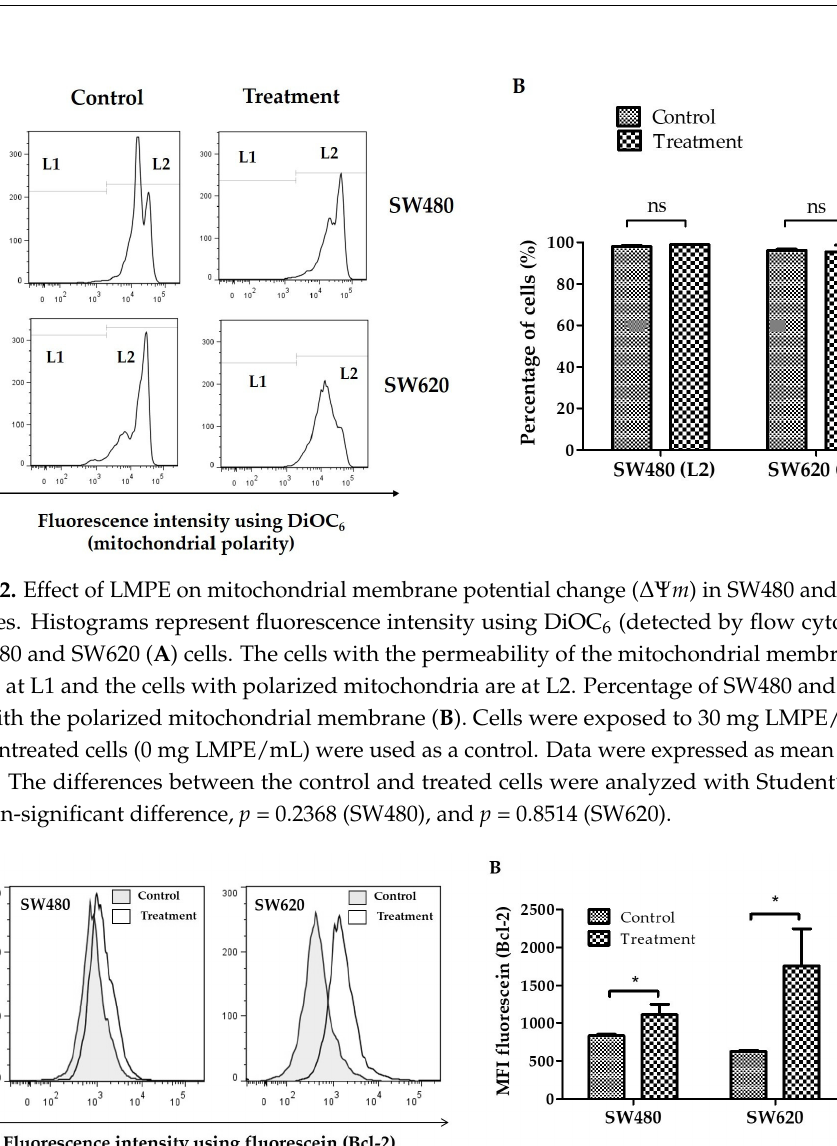
Figure 3. Effect of LMPE on Bcl-2 expression in SW480 and SW620 cell lines. Histograms represent fluorescence intensity using anti-Bcl-2, mouse monoclonal and goat anti-mouse IgG (H + L), fluo- rescein conjugate (detected by flow cytometry) in SW480 and SW620 ( A ) cells. Bcl-2 expression is indicated by the mean fluorescence intensity (MFI) of fluorescein in SW480 and SW620 ( B ) cells. Cells were exposed to 30 mg LMPE/mL for 48 h. Untreated cells (0 mg LMPE/mL) were used as a control. Data were expressed as mean ± SEM ( n = 3). The differences between the control and treated cells were analyzed with the Student’s t test. The significant differences were expressed as * p < 0.05.